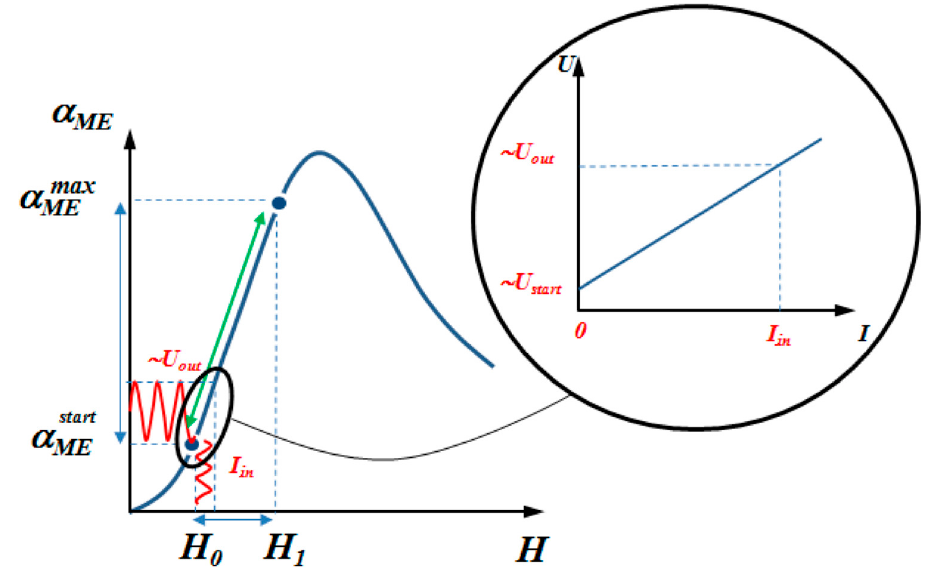
Figure 7. The operating principle of the ME current sensor.